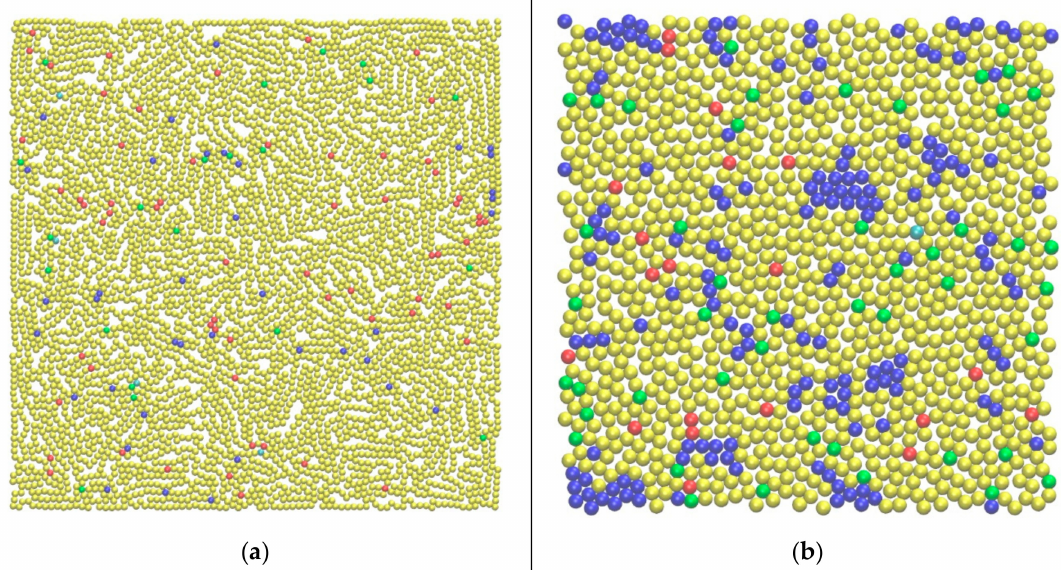
Figure 11. Snapshots of MC simulations on thin-films of linear, hard-sphere chains. ( a ) 48-chain N av = 100 at ϕ = 0.40 under confinement in all dimensions. ( b ) 100-chain N av = 12 at ϕ = 0.40 with confinement in the short dimension and periodic boundary conditions in the long ones. In both cases inter-wall distance in the small dimension corresponds to a single layer. Spheres are color-coded according to the X -crystal similarity ( ε X < ε thres = 0.245) as identified by the value of the CCE norm. Blue, red, greenandcyancolorscorrespondtoTRI,SQU,PENandHONsymmetries, respectively. Amorphous (or unidentified) sites are shown in yellow color. Image created with the VMD software. Each figure panel is also available as stand-alone image in 3-D, interactive format in the Supplementary Materials.